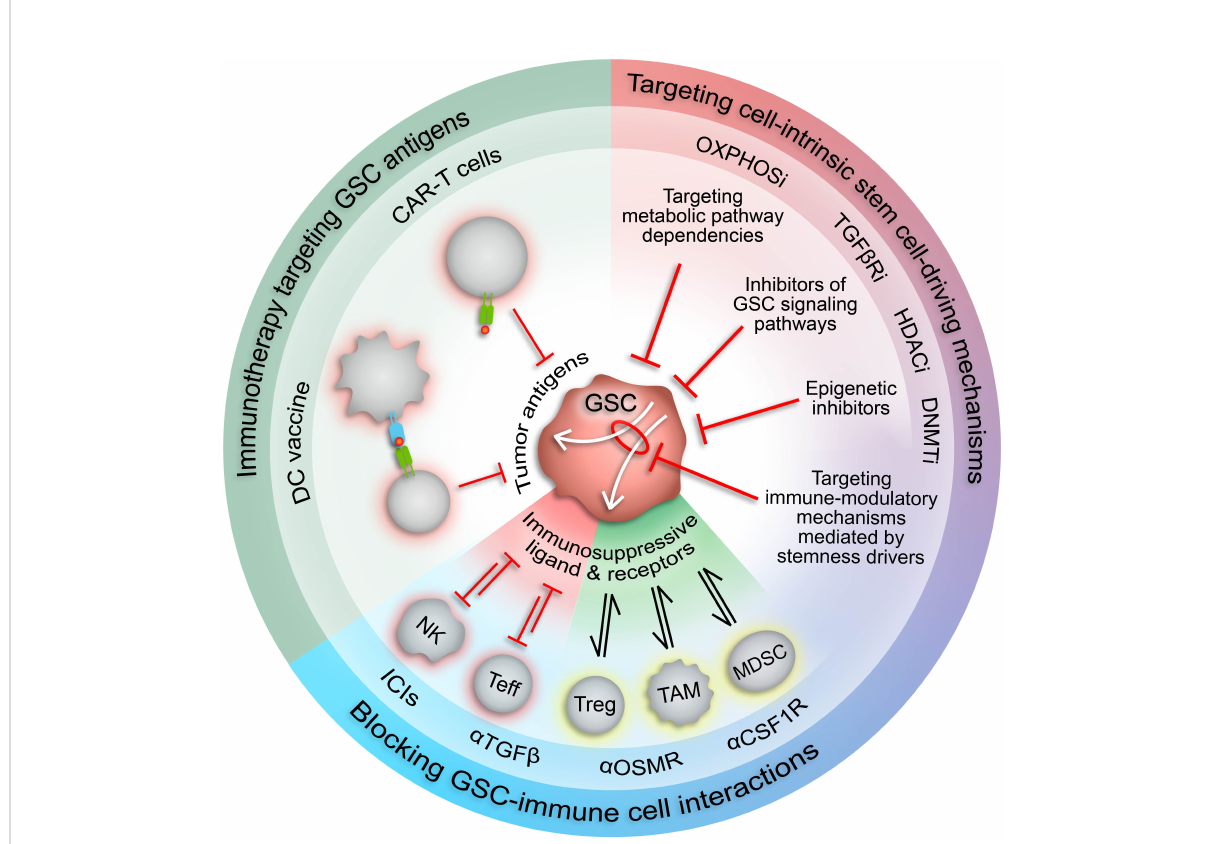
FIGURE 3 Therapeutic approaches to target immunosuppressive GSCs. Increased understanding of the malignant properties of GSCs and their inherent plasticity and heterogeneity has designated GSCs as desirable therapeutic targets. The role of GSCs in driving and maintaining an immunosuppressive TME suggests that GSC-targeted therapies could potentiate current immunotherapies. Targeting stemness mechanisms that also mediate immunosuppressive mechanisms in GSCs (white arrows) has the potential to augment immunotherapy response in GBM by increasing expression of tumor-speci fi c antigens and repressing immunosuppressive cell interactions. CAR-T cell, chimeric antigen receptor T cell; DC, dendritic cell; NK, natural killer cell; Teff, effector T cell; Treg, regulatory T cell; TAM, tumor-associated macrophage/microglia; MDSC, myeloid-derived suppressor cell; ICIs, immune checkpoint inhibitors; HDACi, HDAC inhibitors; DNMTi, DNMT inhibitors; TGF b Ri, TGF b receptor inhibitors; OXPHOSi, oxidative phosphorylation